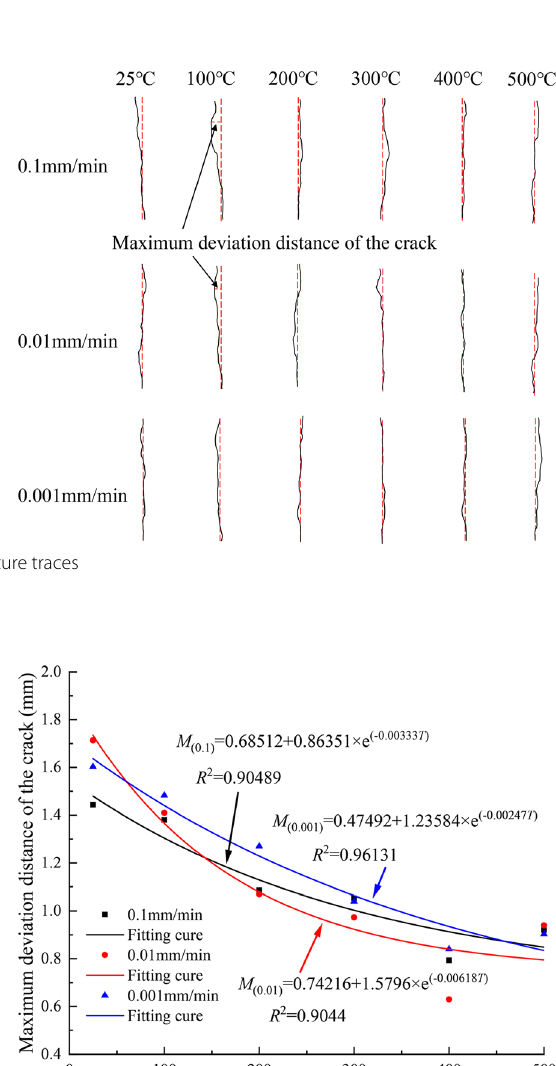
The maximum deviation distance of the crack (Fig. 8) is defined as the perpendicu- lar distance from the crack to the center line of the prefabricated straight notch plane (Wong et al. 2019). As shown in Fig. 9, temperature has a significant effect on the maxi- mum deviation distance, and the temperature reduces the deviation distance of the cracks. The reason is that the high temperature reduces the strength of the rock, and cracks are more likely to expand axially along the prefabricated straight notch under load (Feng et al. 2017). Based on the research of Kuruppu et al. (2014), the maximum deviation distance of the crack should be less than 0.05D, otherwise the sample is sub- jected to the torsion and shear (i.e., I–II mixed mode fracture occurs). Our test results in Fig. 9 shows that the maximum deviation distance of the crack is 1.71 mm, indicating that pure tensile failure occurs. The maximum deviation distance of the cracks is close to each other for NSCB samples under different loading rates, indicating the loading rate